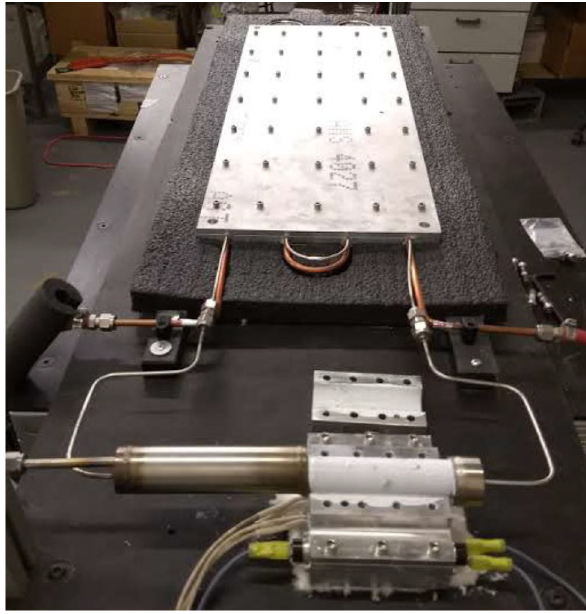
Figure 8. Complete LHP